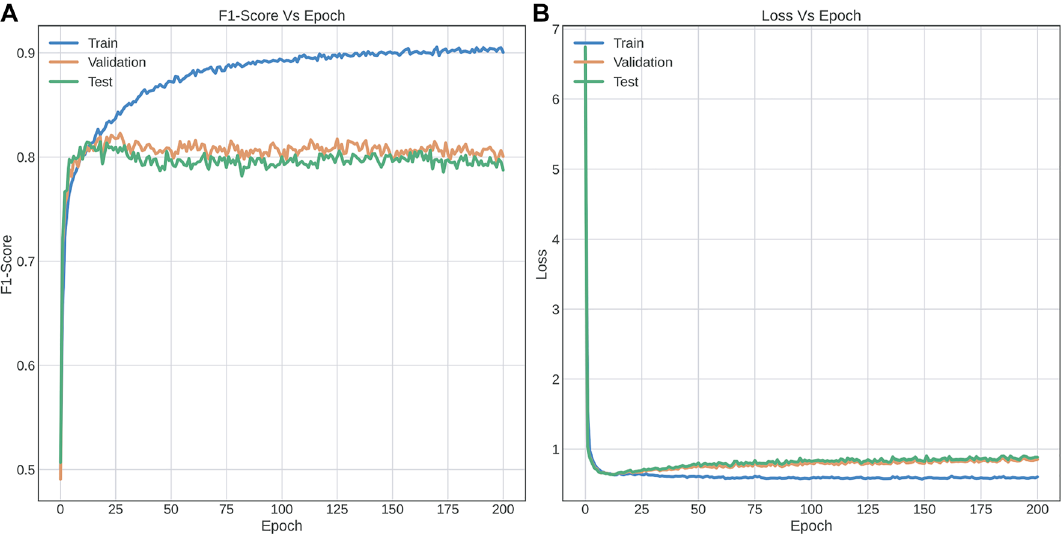
Figure 10: Training curves with CNN implemented for binary classification (A) F1-score vs. epochs (B) Loss vs. epochs.